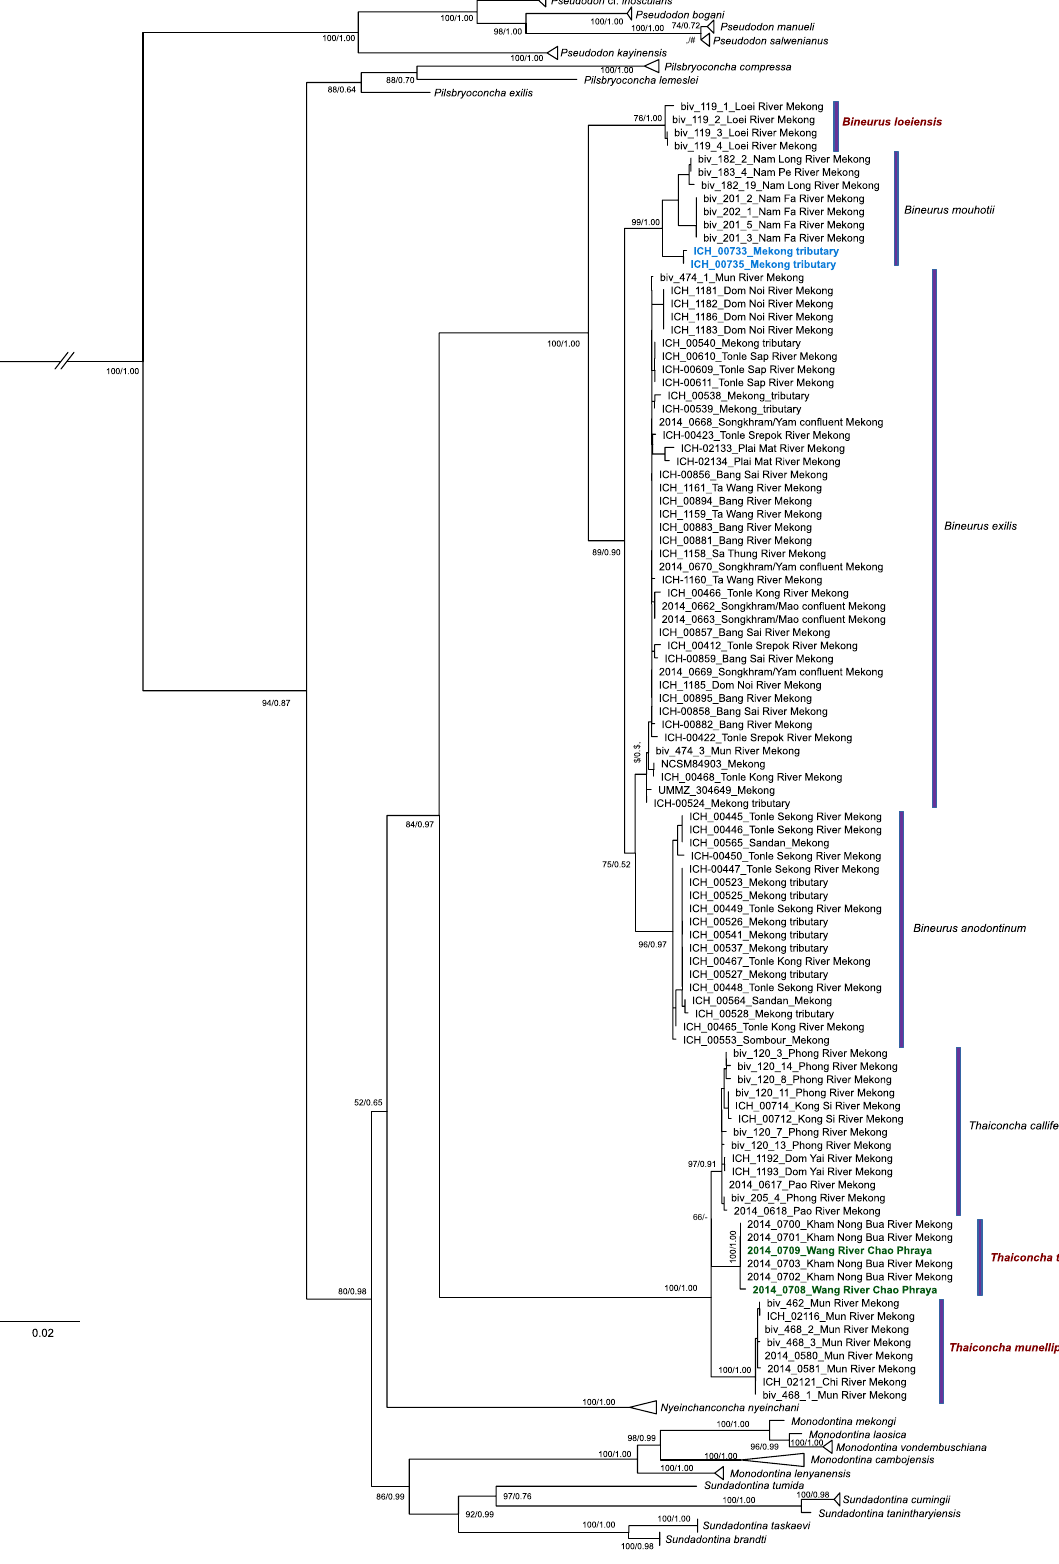
Figure 1. Maximum likelihood phylogeny of the complete data set of mitochondrial and nuclear sequences (five partitions: three codons of COI + 16S rRNA + 28S rRNA ). Outgroup is not shown. Black numbers near nodes are ML Bootstrap Support values (BS)/Bayesian Posterior Probabilities (BPP). The new species names are red; the divergent lineage of Bineurus mouhotii is blue; the Chao Phraya’s lineage of Thaiconcha thaiensis is